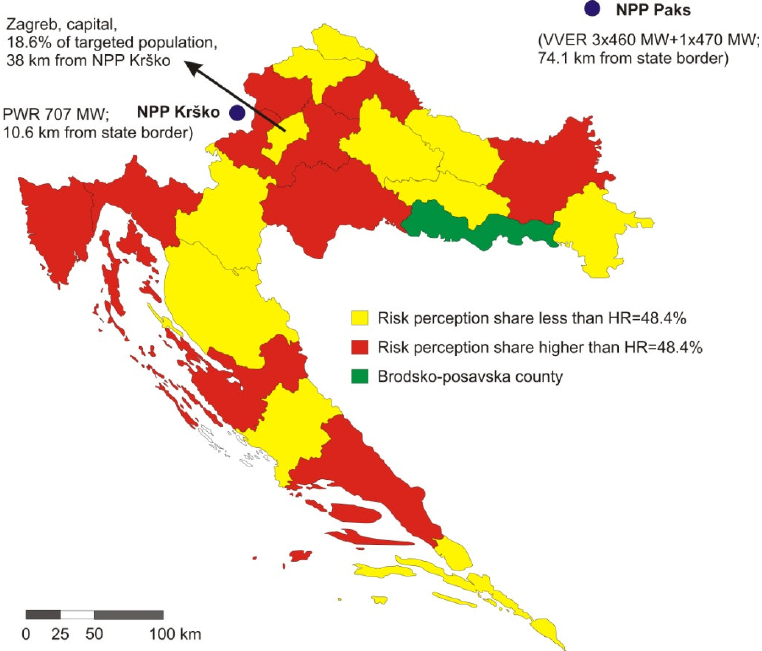
Figure 4. Regional distribution of risk perception from nuclear power plants with respect to national level.